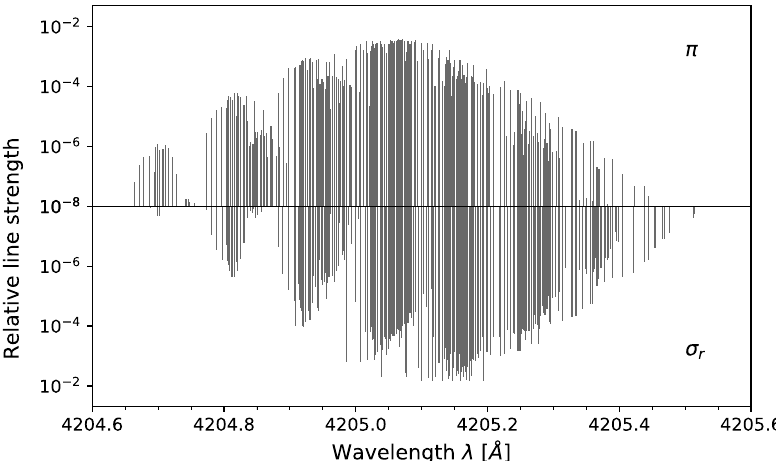
Figure 2. Relative line strengths of the magnetic-field split hyperfine components within the 4205Å fine-structure transition of 151,153 Eu + 1 in a natural abundance mix under influence of a uniform external magnetic field of 6kG. The π ( δ M F = 0) components and σ r ( δ M F = + 1; red-shifted) components are shown in the upper and lower panels, respectively. The relative line strengths are presented in log 10 scale, and transitions with a relative strength smaller than 10 − 8 are excluded. This figure is inspired by Figure 3.12 in the book Polarization in spectral lines by Landi Deg’Innocenti and Landolfi